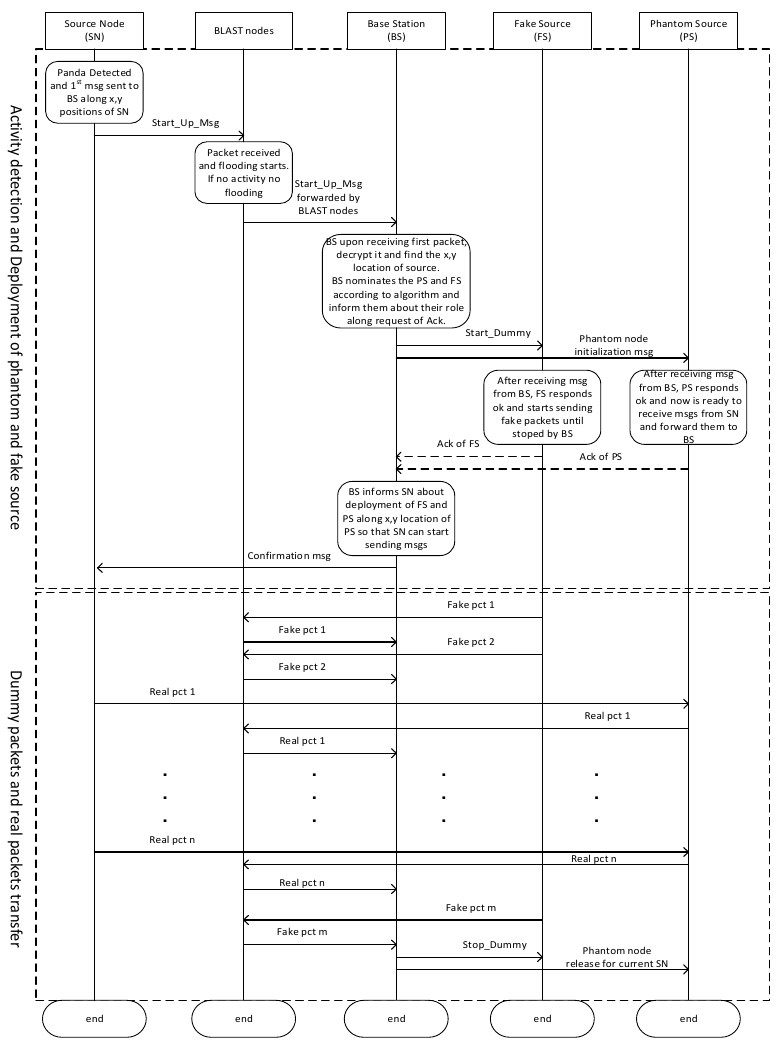
Figure 9. Timing Diagram of the proposed technique from the deployment till release of the SN.